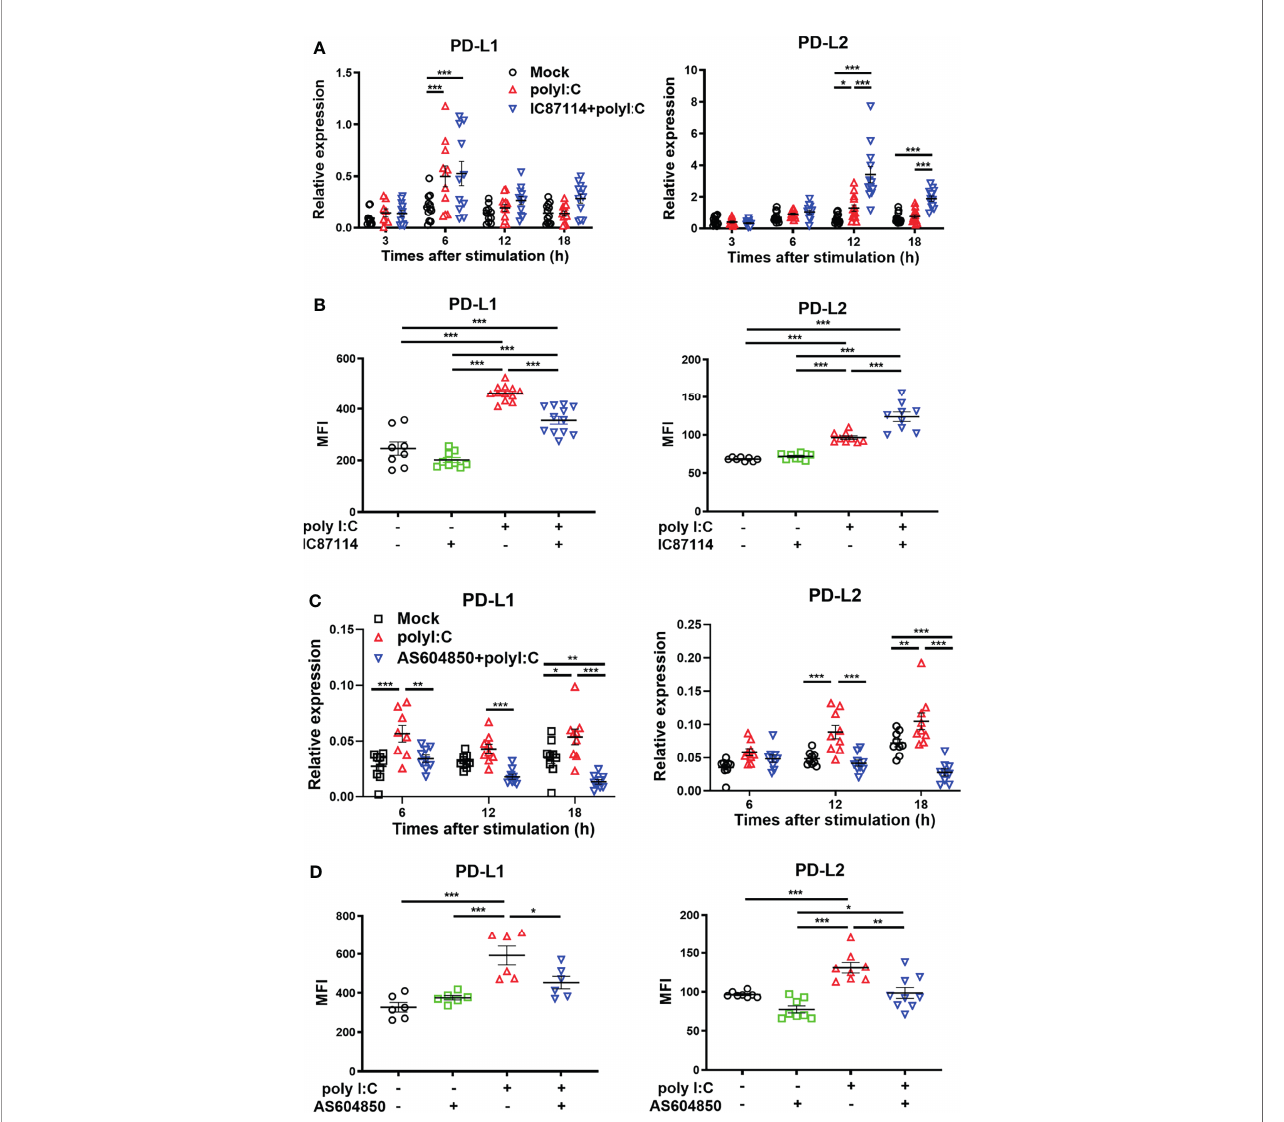
FIGURE 3 | A PI3K d inhibitor enhances poly I:C – induced PD-L2 expression on PBECs and suppresses poly I:C – induced PD-L1 expression. PBECs were pretreated with 10 m M the PI3K d inhibitor IC87114 (A, B), 10 m M the PI3K g inhibitor AS604850 (C, D) , or vehicle for 1 h and then stimulated with 1 m g/mL poly I:C for the indicated times. (A, C) PD-L1 and PD-L2 gene expressions were measured by real-time quantitative reverse-transcription PCR and normalized to that of 18S rRNA. (B, D) PD-L1 expression and PD-L2 expression were analyzed 24 h following stimulation using fl ow cytometry. Data represent means ± SEM (n=6 – 12 per group) and were pooled from a minimum of two independent donors with three replicates. * p <0.05, ** p <0.01, *** p <0.001 by one- or two-way ANOVA as appropriate. MFI, mean fl uorescence